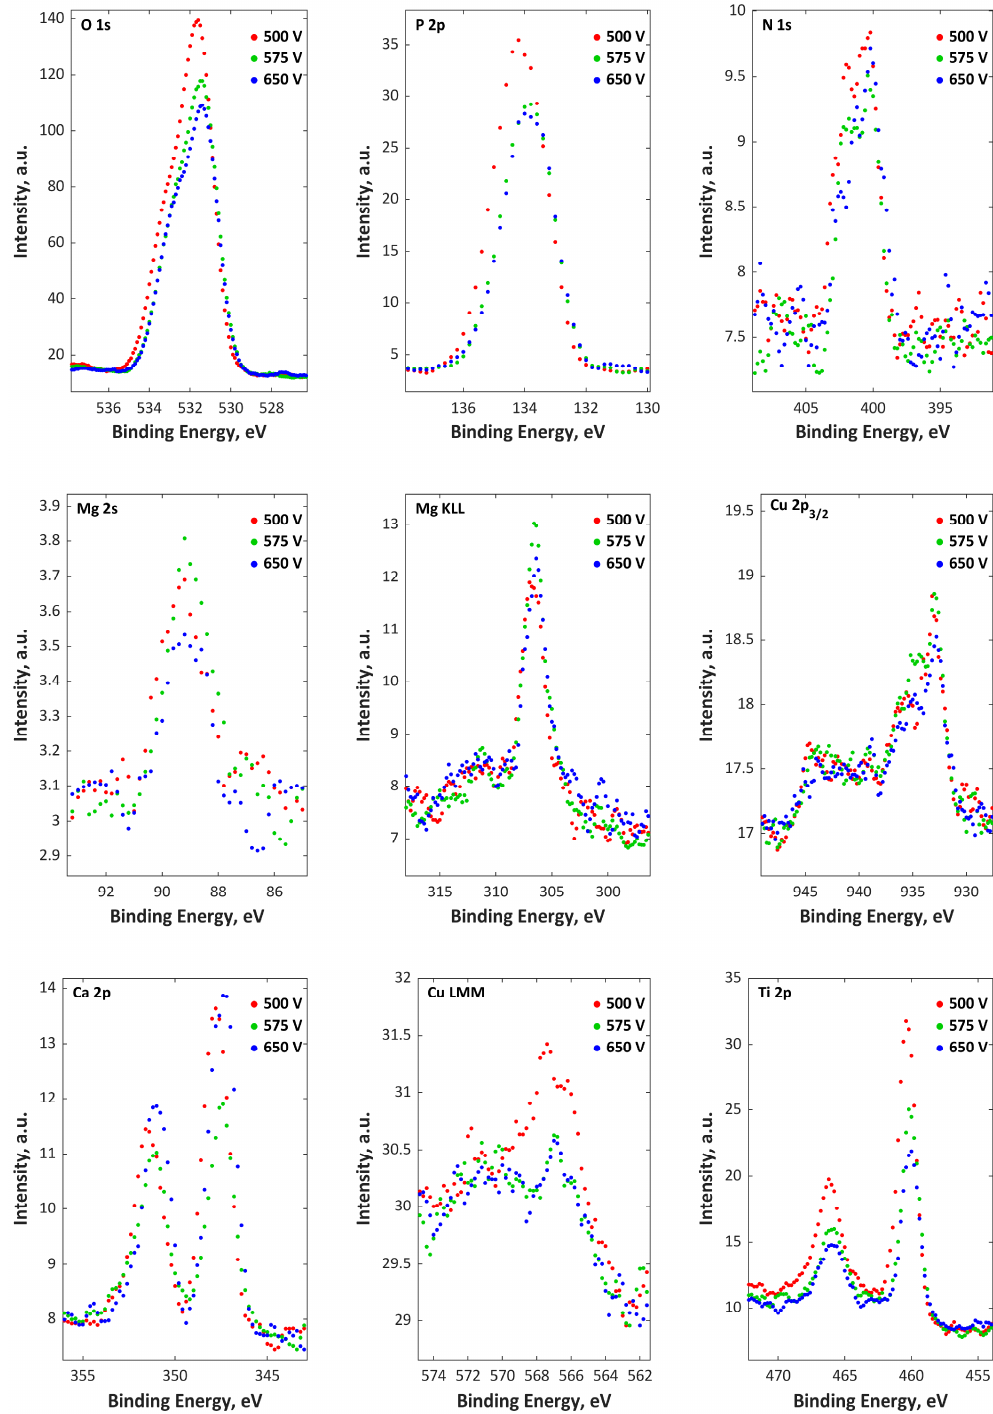
Figure 8. XPS spectra for titanium samples after PEO treatment in Electrolyte 2.